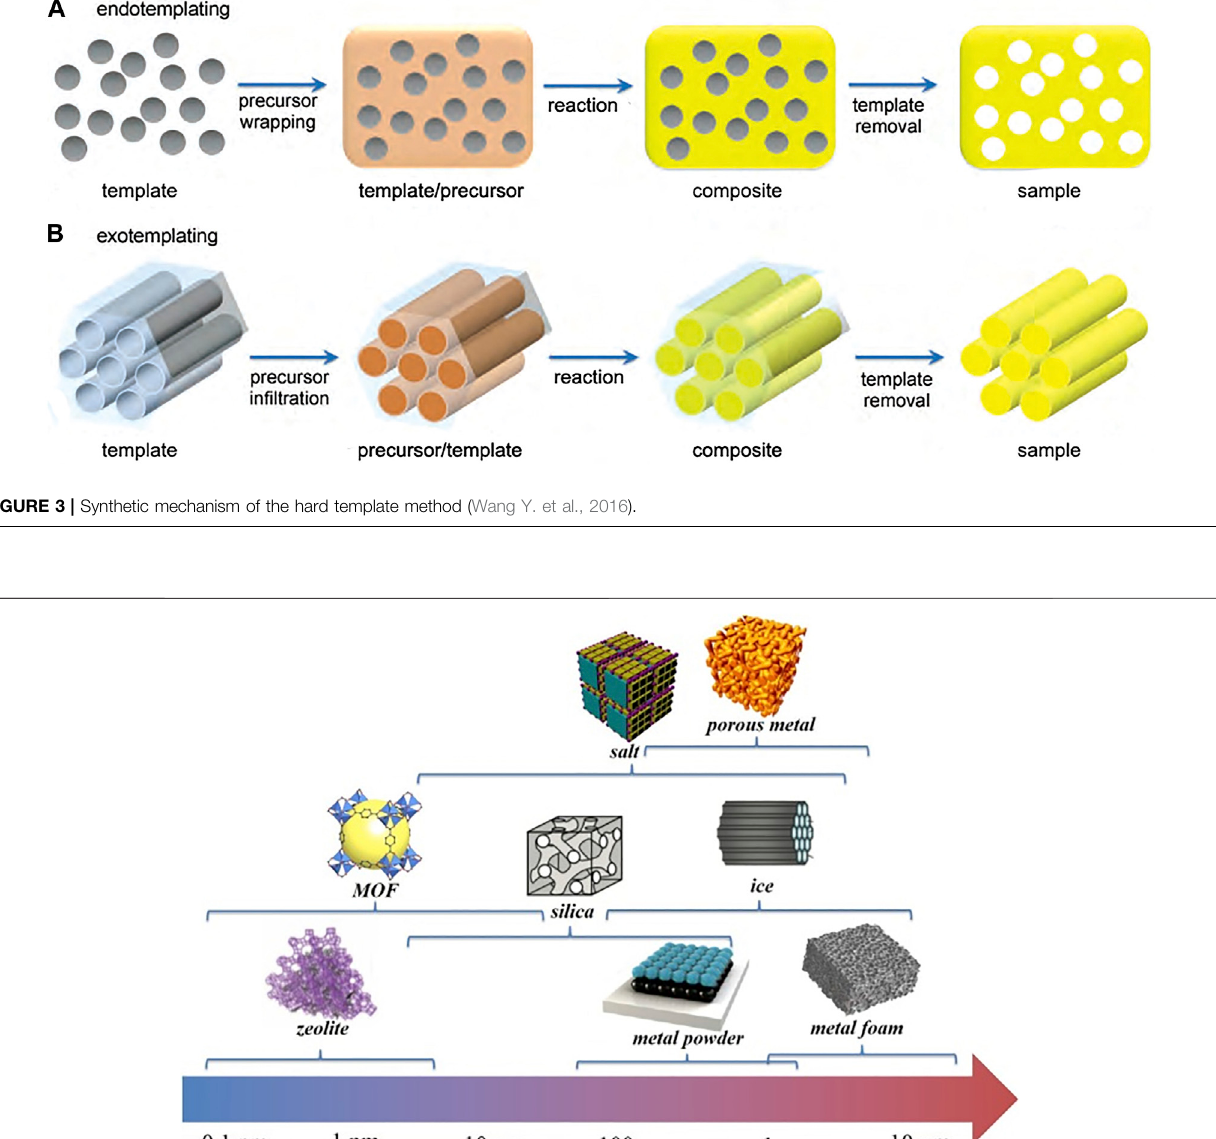
Frontiers in Chemistry |